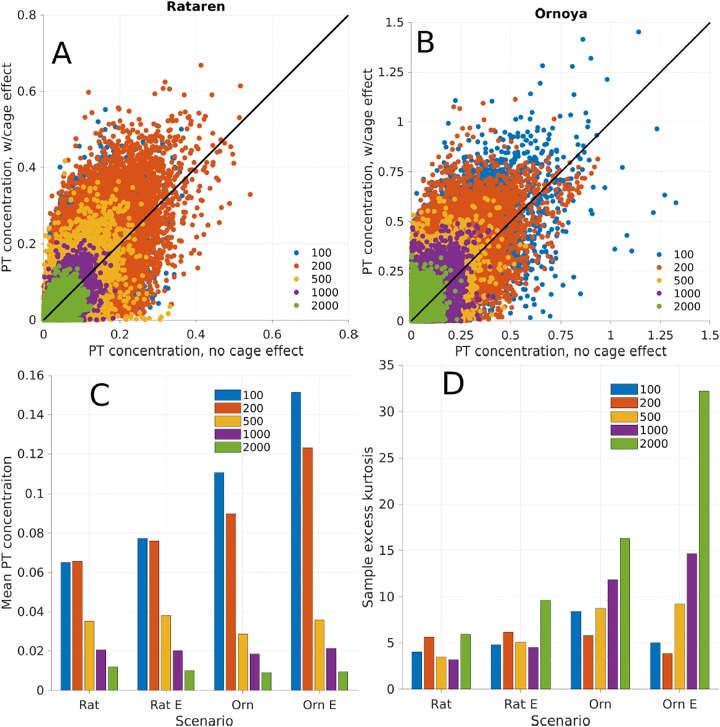
Passive tracer concentrations at selected distances from the farm centres.A, B: Scatter plots of simulated passive tracer concentrations at 10 m depth with (ordinate) and without (abscissa) cage effects at Rataren (A) and Ørnøya (B). Each point represents a sample in time and space at the distance indicated by the color from the two scenarios (Aug-Sep, 2015 and May-Jun, 2016) combined. A complete circle (excluding land points) around the farm centre was sampled with radius indicated by the colors. A 7 day spinup was used to allow the passive tracer to disperse sufficiently. C: Means of the simulated passive tracer concentrations at the distances sampled in A, B for the same time periods and for the two farms with and without cage structure effects. Inclusion of the cage strucutres is indicated by an “E” in the labelling. D: Sample excess kurtosis of the data presented in A, B, and C for each farm and scenario.